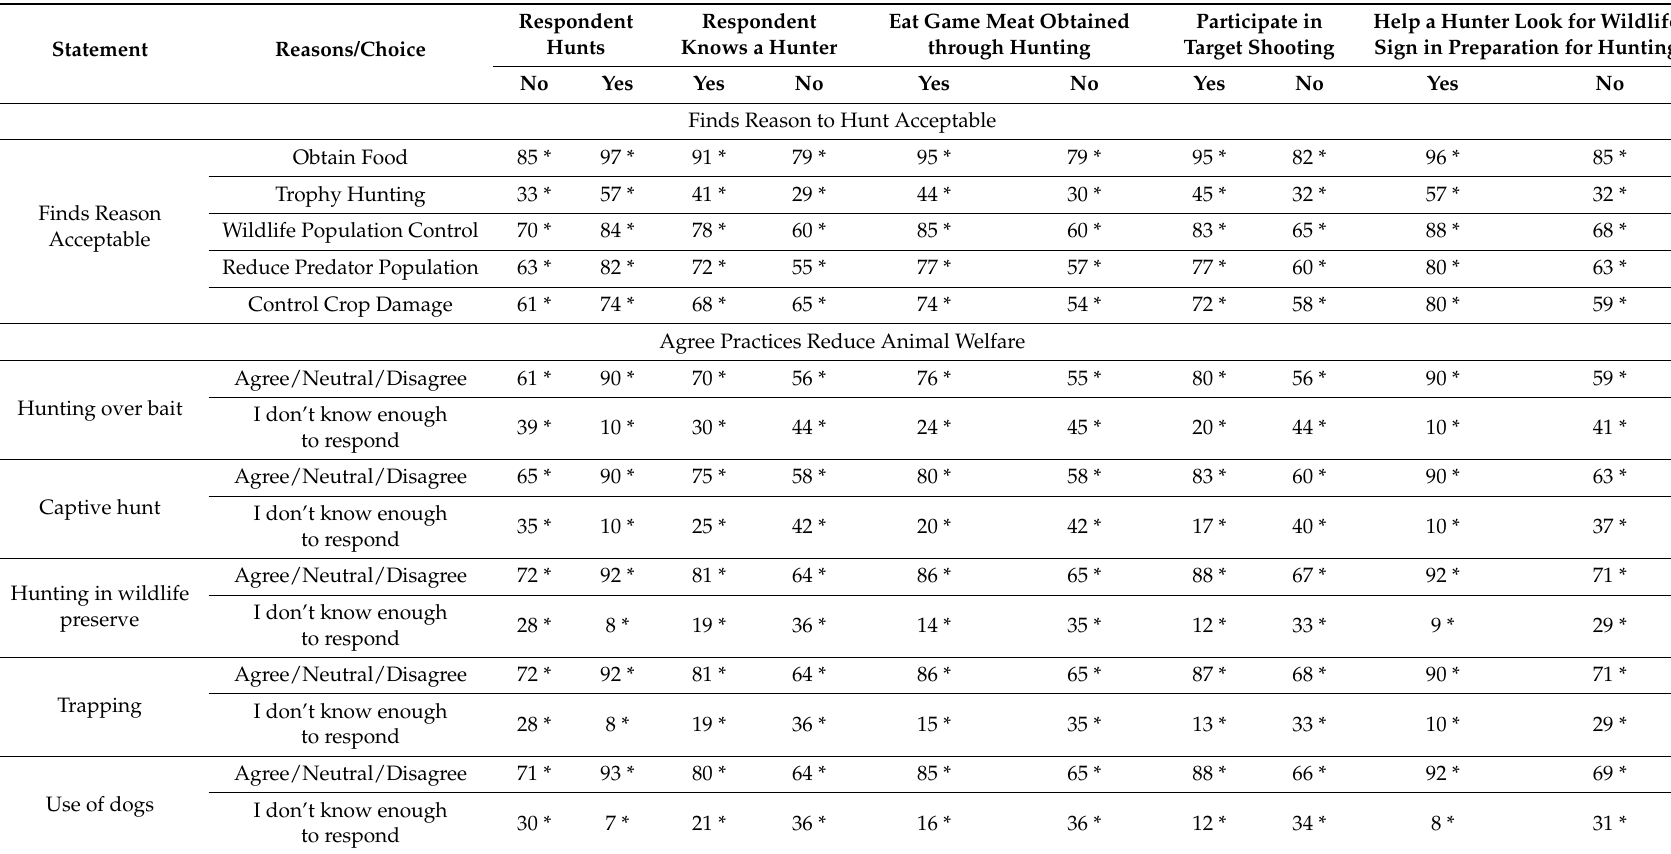
Table 4. Presentation of statistically significant differences in hunting acceptance across familiarity with hunting ( α = 0.05 denoted by